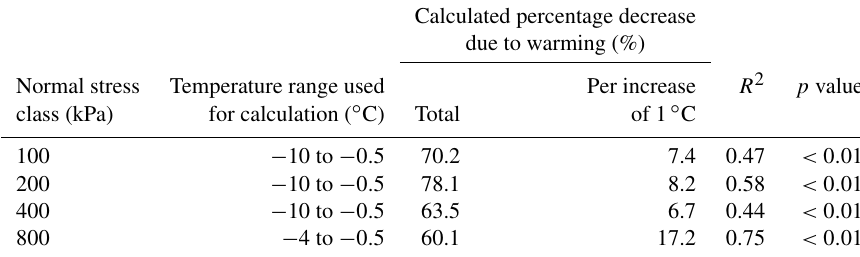
Table 1. Calculated decrease in shear stress at failure with increasing